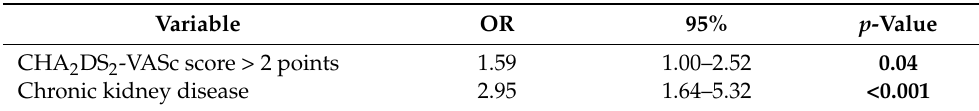
Table 4. Multiple logistic regression analysis to predict the likelihood of ST-segment elevation myocardial-infarction-related hemodynamic